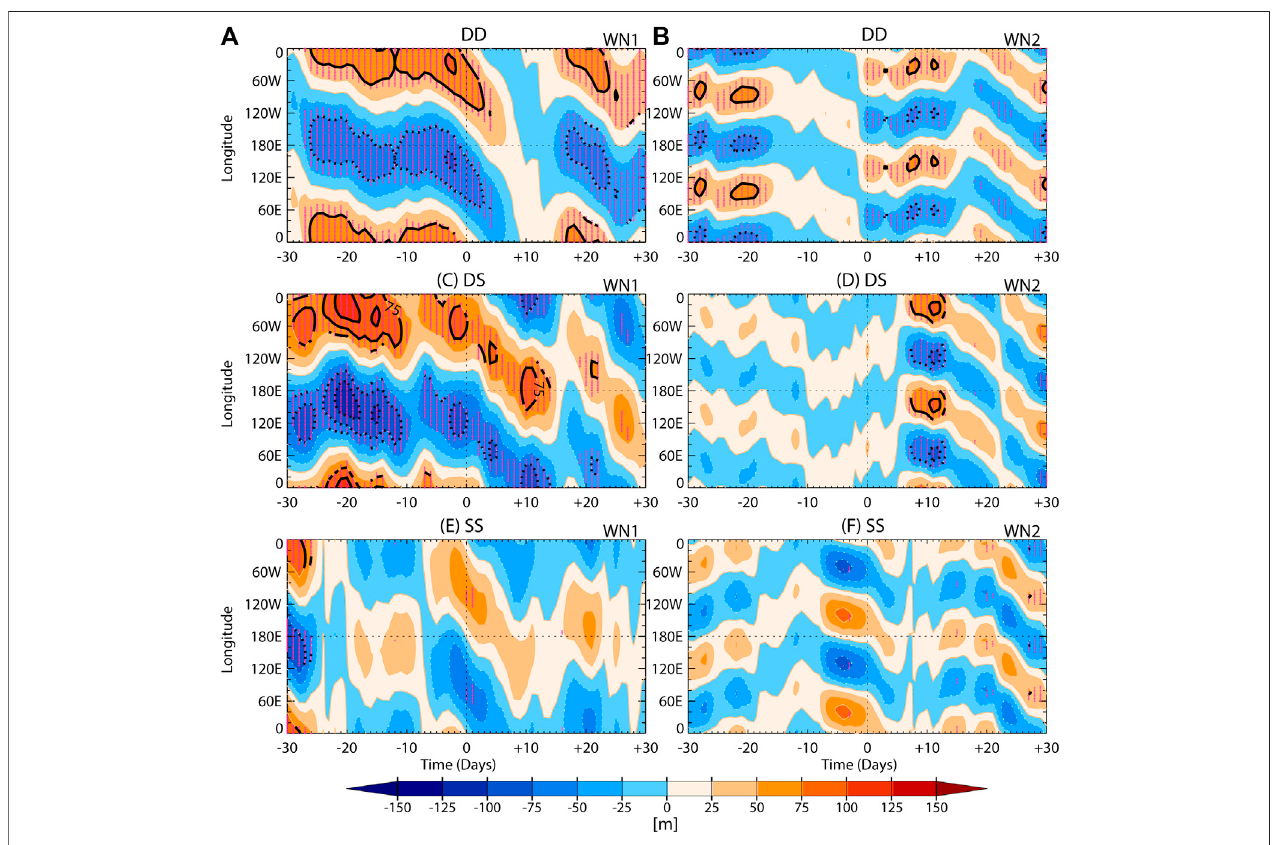
FIGURE5| Time-longitudesectionsoftheanomalousgeopotentialheight (A,C,E) wave1,and (B,D,F) wave2averagedover60 ° N – 70 ° Nat300 hPafor (Top) DD, (Middle) DS, and (Bottom) SS SSW types. The color interval is 25 m. Bold contours and pink dots indicate signi fi cant regions at 90% con fi dence level.